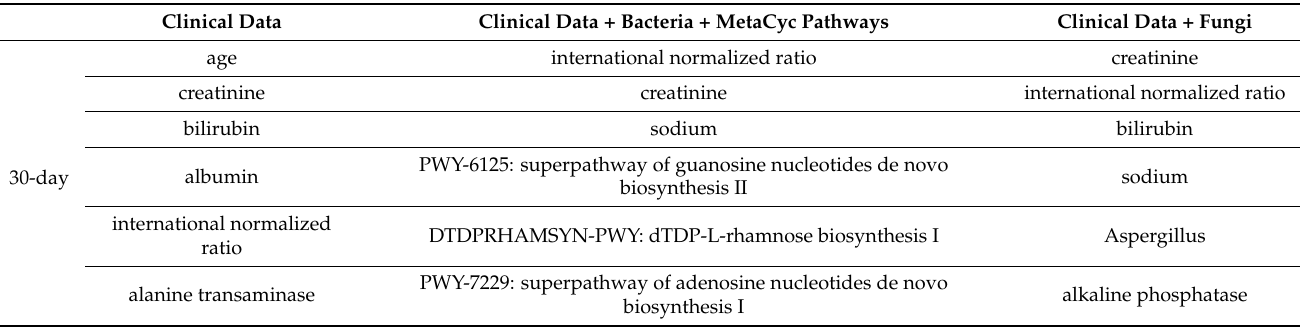
Table 2. Variables with the top 11 average feature importance in each